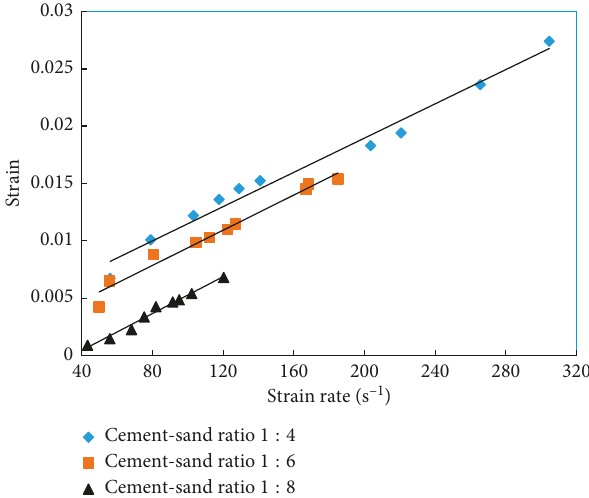
Figure 7: The strain and strain rate